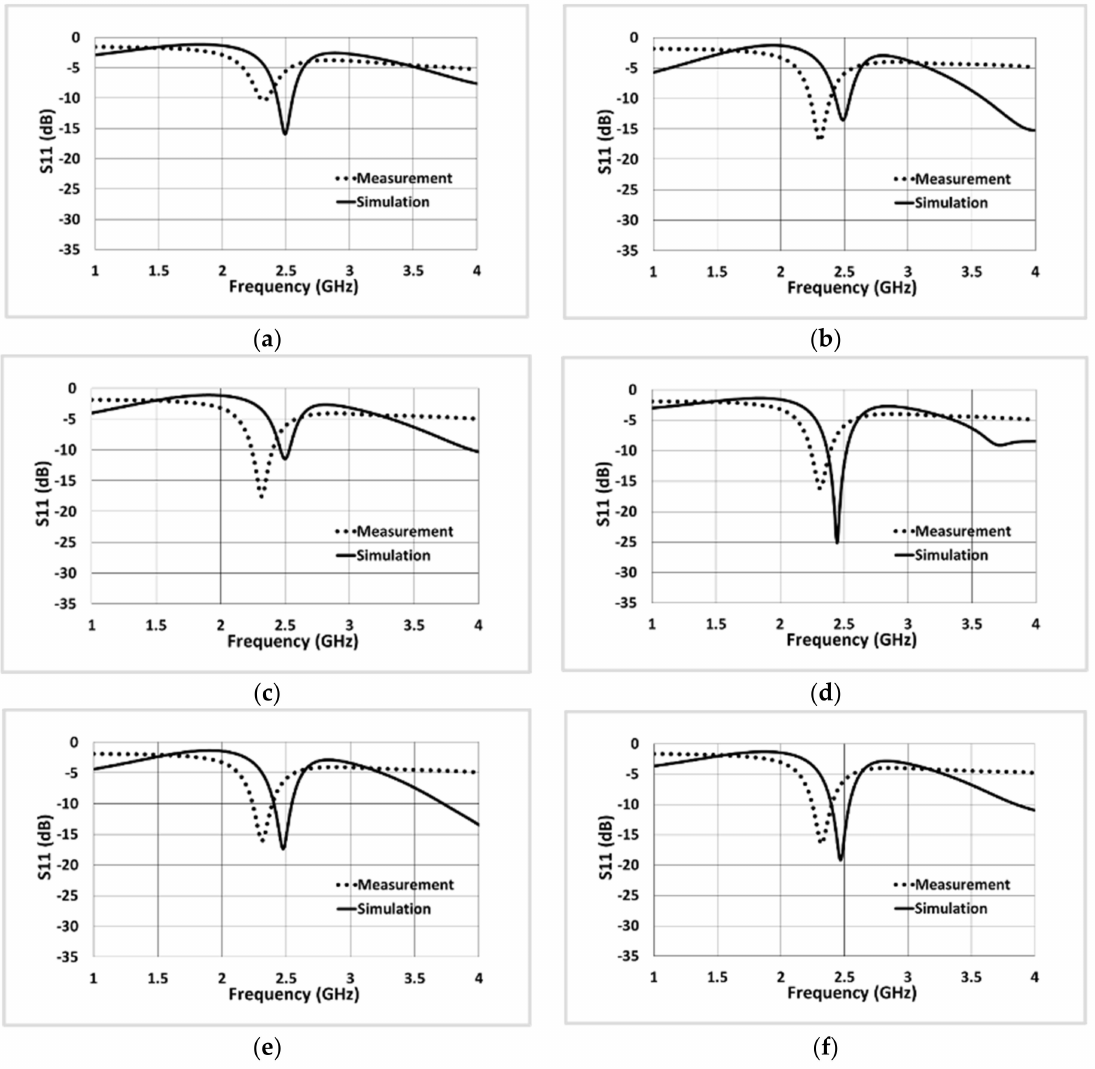
Figure 10. Simulated and measured input reflection coefficient ( S 11 ) of the 3D-printed conformal antenna prototype on ( a ) flat surface; ( b ) cylindrical surface of radius 43 mm; ( c ) cylindrical surface of radius 50 mm; ( d ) cylindrical surface of radius 60 mm; ( e ) cylindrical surface of radius 75 mm; and ( f ) cylindrical surface of radius 88